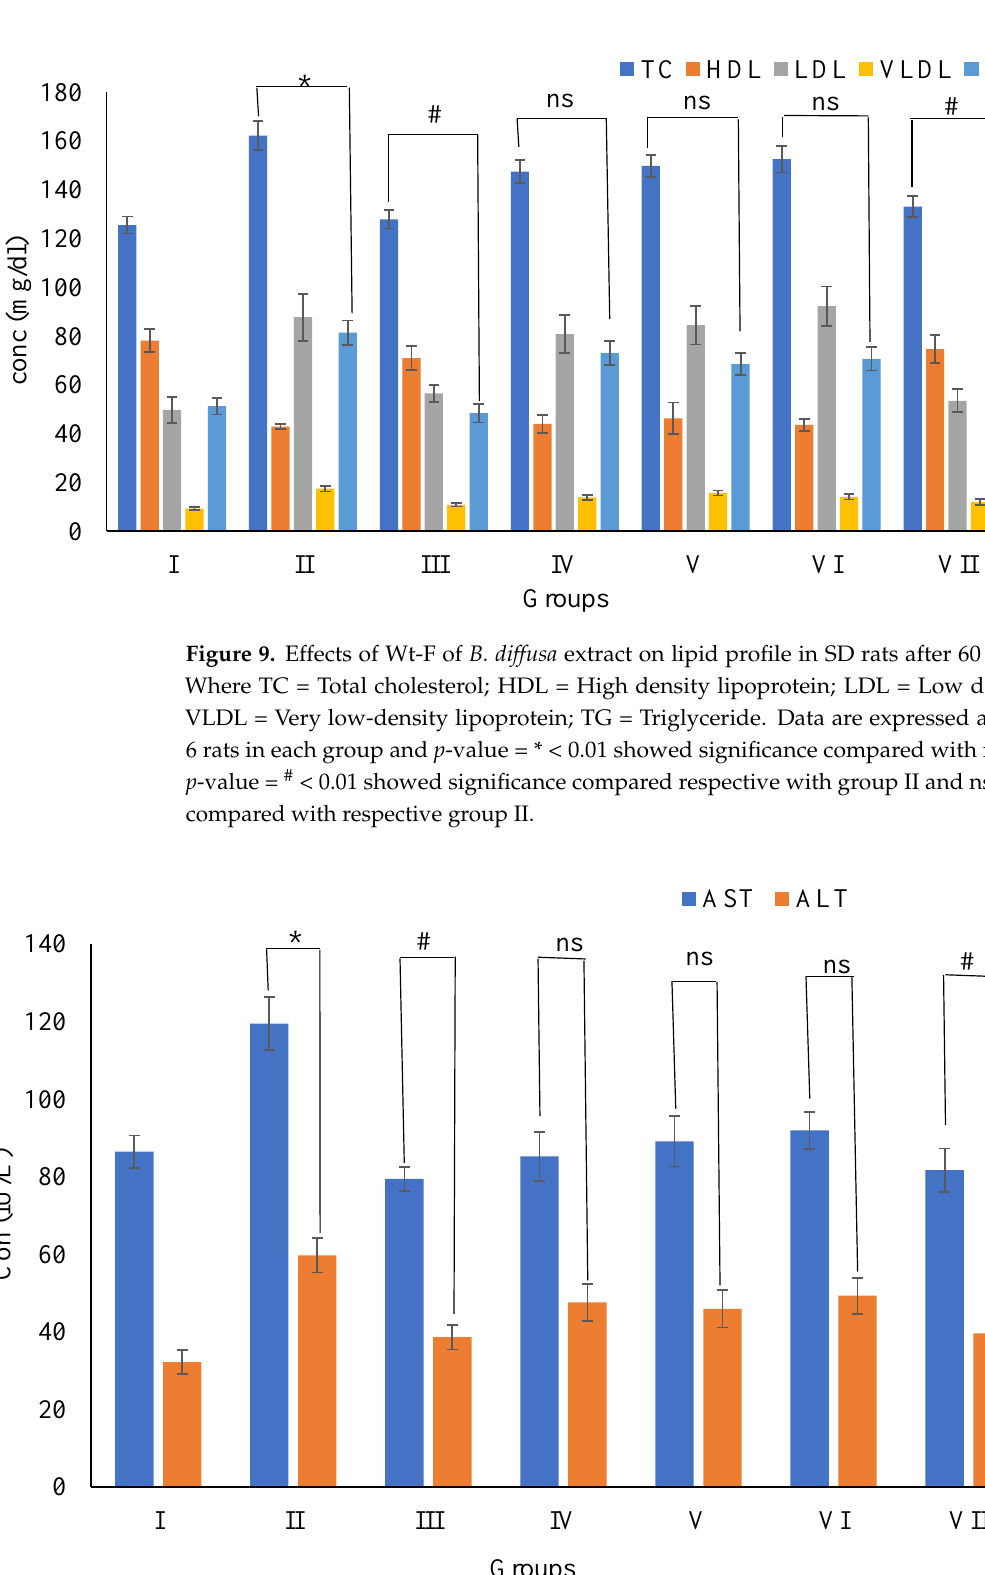
13 of 20 Effects of Wt-F of B. diffusa Extraction Lipid Profile in SD Rats Figure 9 shows that TC (162.17 ± 5.92 mg/dl), LDL (87.74 ± 9.59 mg/dl), VLDL (17.47 ± 1.19 mg/dl), and TG (81.41 ± 5.04 mg/dl) level was significantly elevated ( p < 0.01). In contrast, HDL (42.94 ± 1.12) levels were lower ( p < 0.01) in group II than in group I. Com- pared to group II animals, sibutramine (5 mg/kg) treated group III animals had lower TC (127.89 ± 3.75 mg/dl), LDL (56.49 ± 3.45 mg/dl), VLDL (10.84 ± 0.67 mg/dl), and TG (48.39